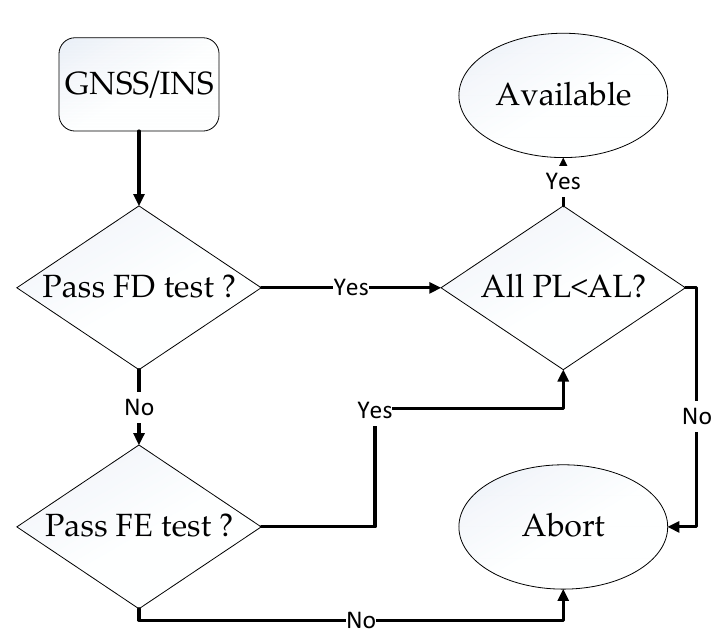
Figure 1. Flow diagram of the fault detection and exclusion process.